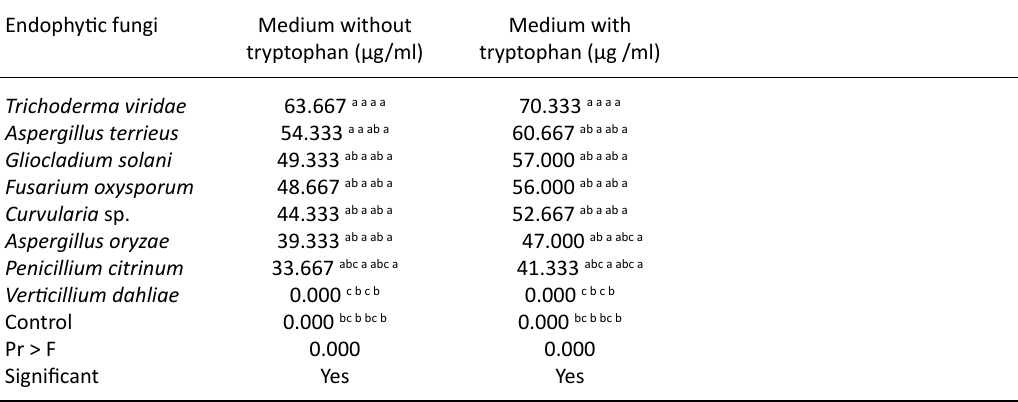
Table 5. Production of IAA by selected eight fungal endophytes Endophytic fungi